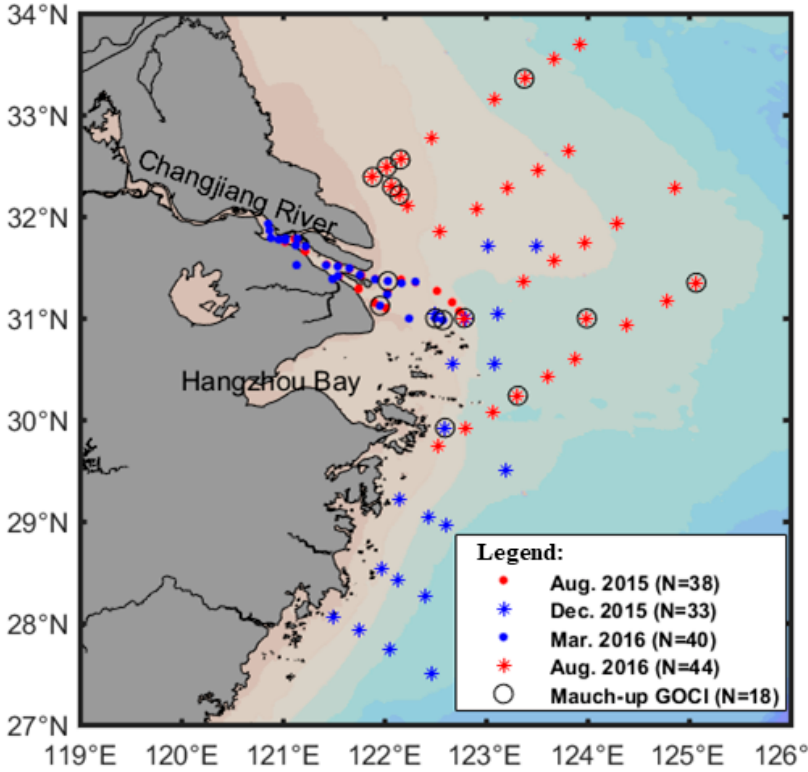
Figure 2. Locations of sampling sites. Two Changjiang Estuary cruises were conducted in August 2015 and March 2016, and two continental shelf cruises were conducted in December 2015 and August 2016. Black circles indicate the sites where the weather was clear during sampling and synchronous satellite observations were obtained.